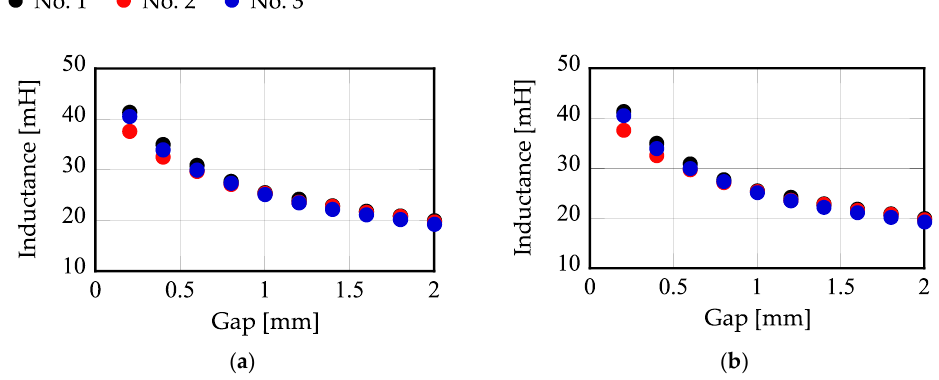
Figure 13. Measured self-inductance of electromagnet at various gaps. ( a ) Primary electromagnet. ( b ) Secondary electromagnet.